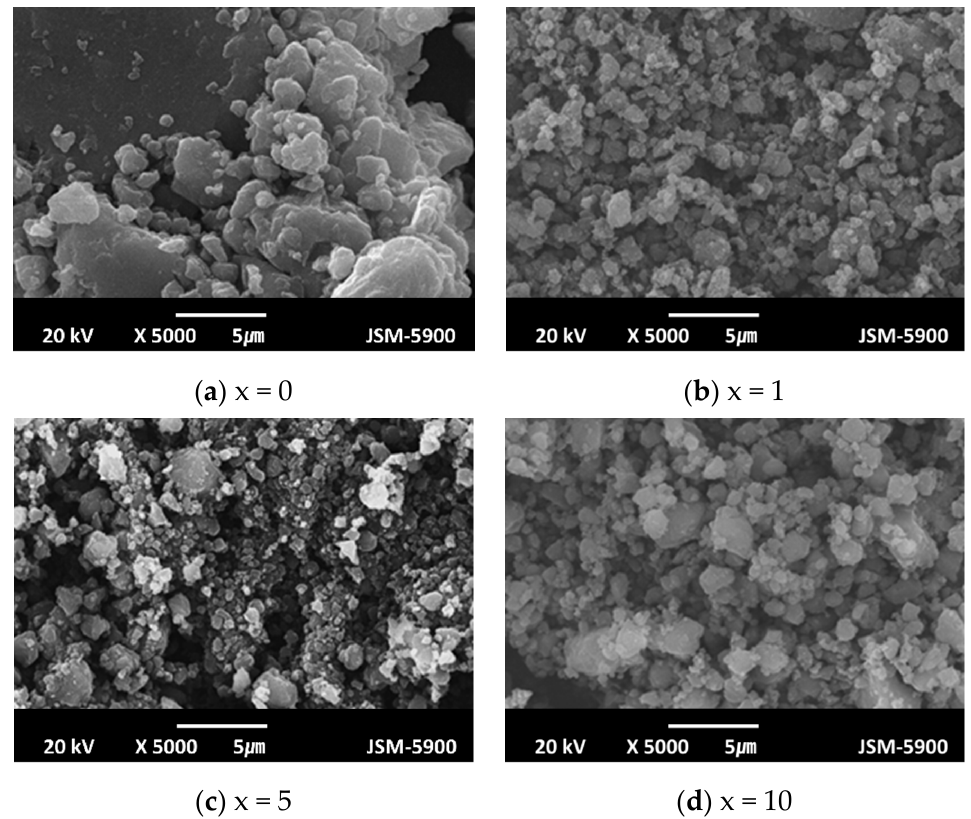
Figure 7. SEM micrographs of Mg-xMgH 2 -1.25Ni-1.25TaF 5 -1.25VCl 3 (x = 1, 1, 5, and 10) after reactive mechanical milling; ( a ) x = 0, ( b ) x = 1, ( c ) x = 5, and ( d ) x = 10.